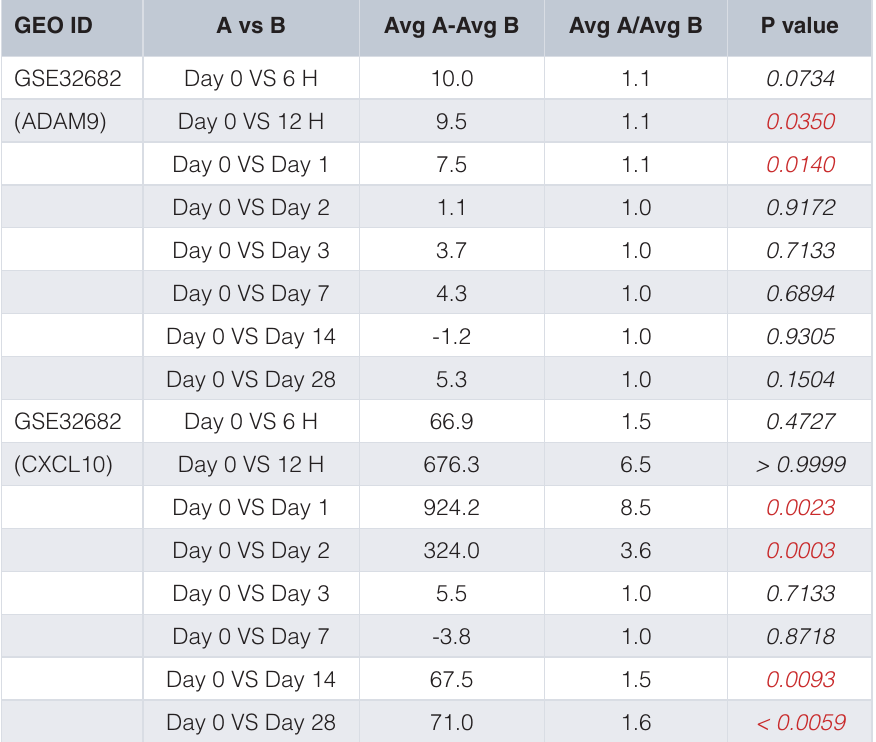
Table 2. Increased abundance of ADAM9 following treatment with